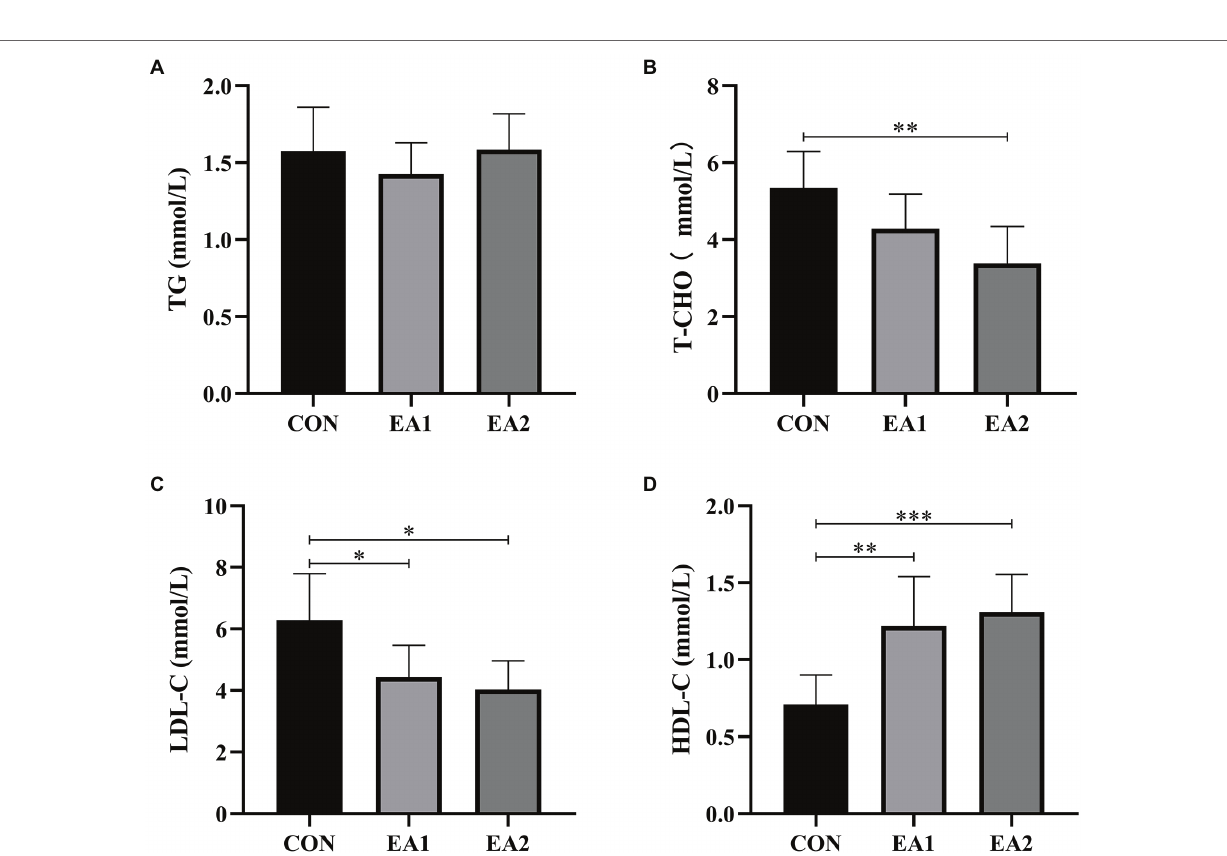
FIGURE 3 | Effects of EA supplementation on lipid profiles in liver. The contents of hepatic triglyceride (TG) (A) , total cholesterol (T-CHO (B) , low-density lipoprotein cholesterol (LDL-C) (C) , and high-density lipoprotein cholesterol (HDL-C) (D) were determined by the ELISA kits. The values are reported as the mean ± SD of 12 mice per group: * p < 0.05, ** p < 0.01, and *** p < 0.001 represent significant differences compared with the control